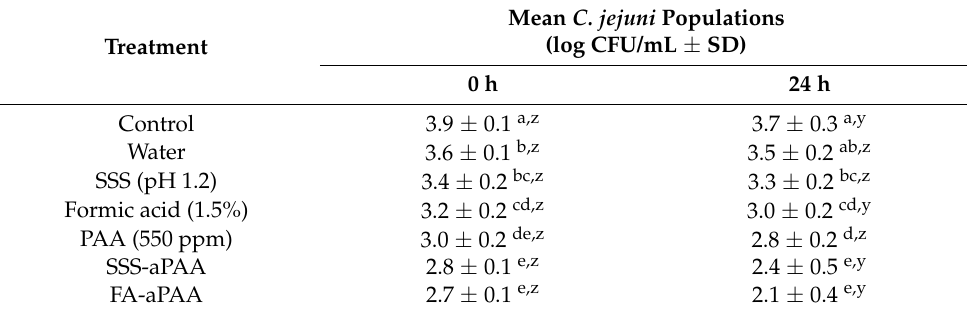
Table 3. Mean ( n = 6) Campylobacter jejuni populations (log colony-forming units [CFU]/mL ± standard deviation [SD]) for inoculated (six-strain mixture; 3 to 4 log CFU/mL) chicken wings that were left untreated (control) or were spray-treated (4 s, 69 to 83 kPa) with various treatment